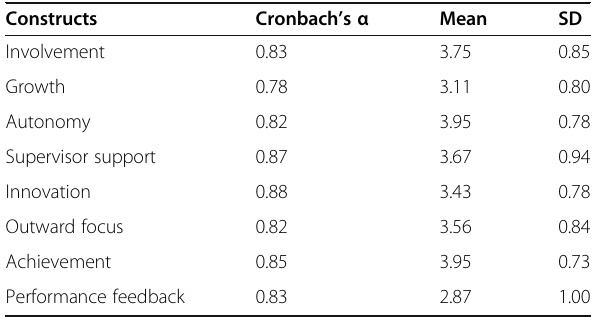
Table 4 Cronbach ’ s alphas, means, and standard deviations for each construct measured in the DCaT survey ( n = 166)